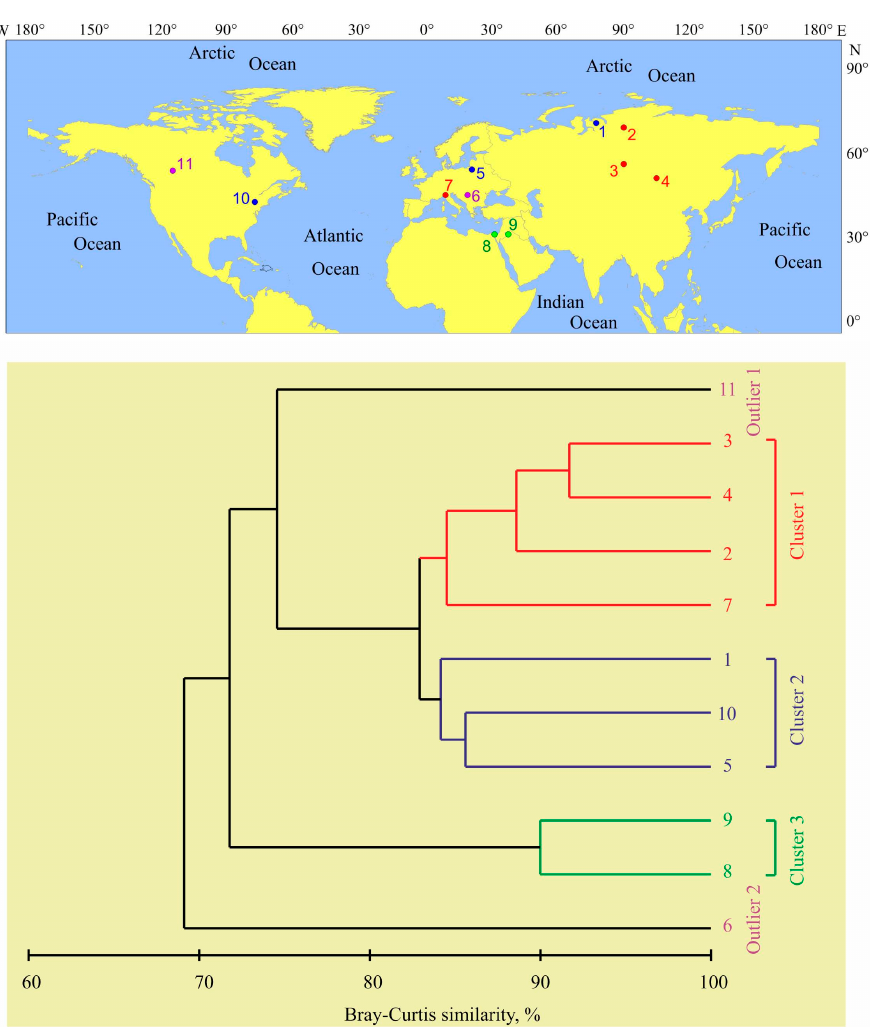
Figure 3. Hierarchical cluster dendrogram of the degree of similarity in the fatty acid content of pike from different locations. For abbreviations, see Figure 1.